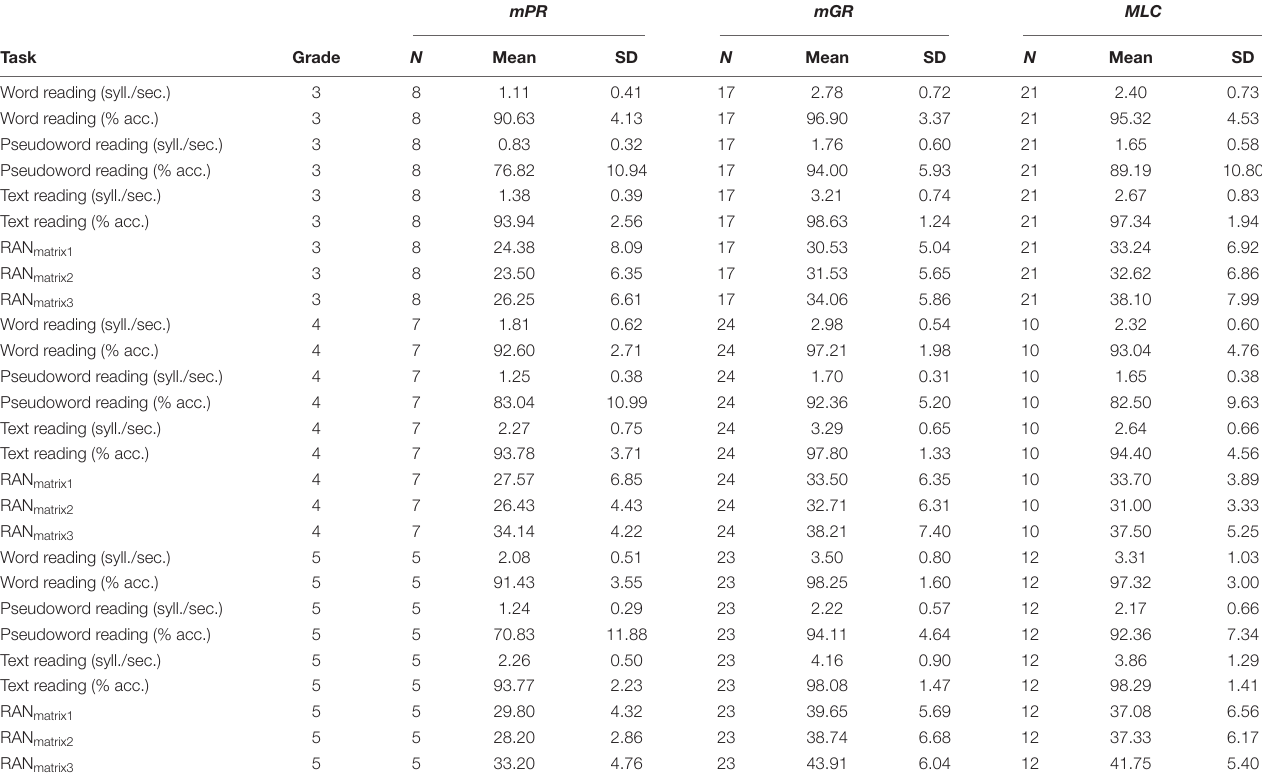
TABLE 5 | Descriptive statistics of reading performances of students in each group and grade.